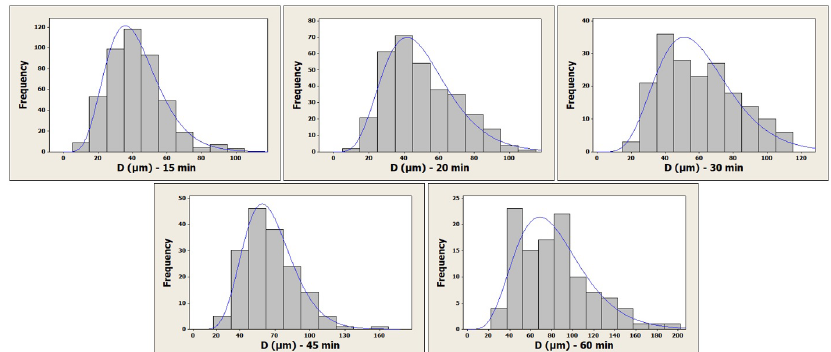
Figure 12. Particle size frequency distribution of the pure ZA27 alloy during the heat treatment. Adjusted to Gamma